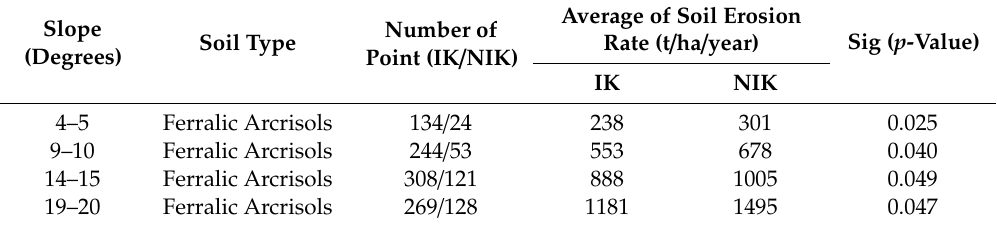
Table 5. A comparison of soil erosion rate between IK and NIK farming